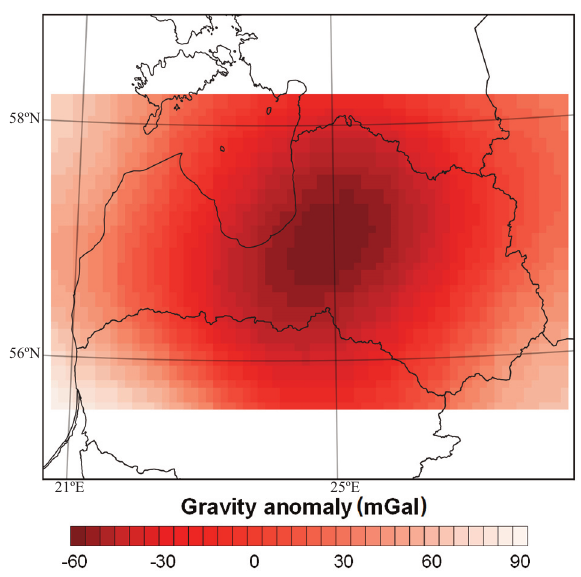
Fig. 6. Modelled gravity response of the European Moho map (Grad et al. 2009). The amplitude of the negative anomaly in the territory of Latvia reaches 142